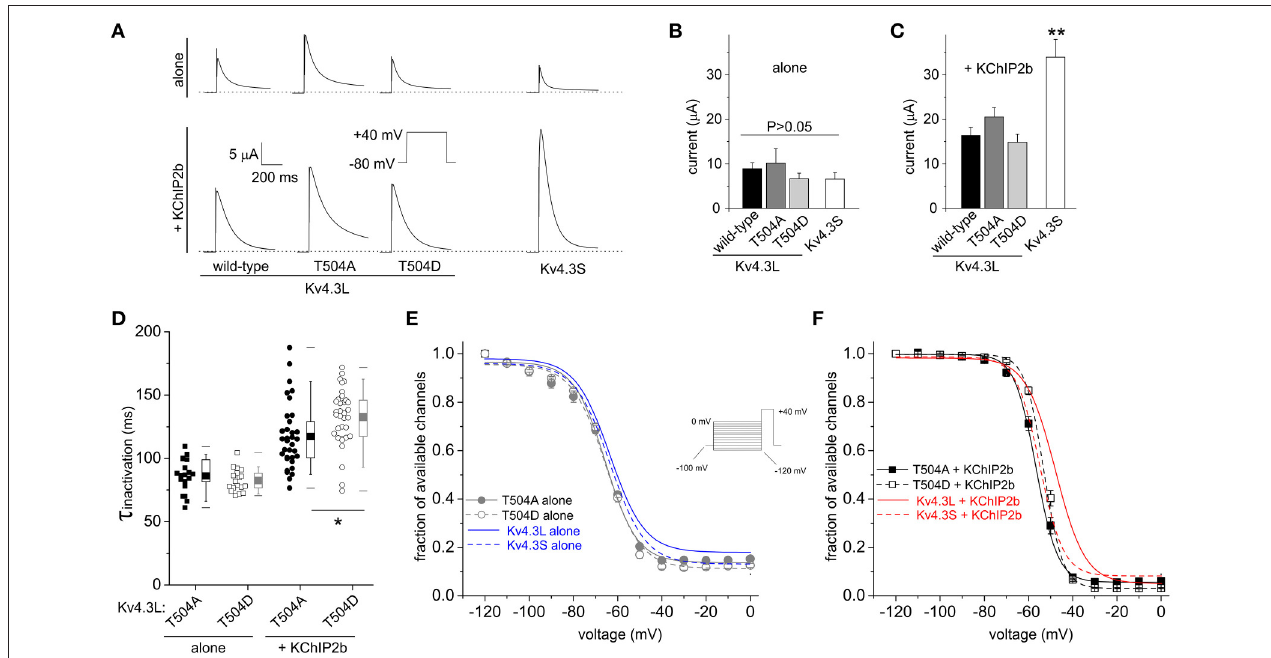
FIGURE 4 | Kv4.3L T504 mutations alter inactivation rate and voltage dependence only with KChIP2b co-expression. (A) Exemplar current traces recorded at + 40 mV from Xenopus oocytes expressing Kv4.3L (wild-type, T504A or T504D) or Kv4.3S, alone or with KChIP2b (voltage protocol inset). Zero current level indicated by dashed line. (B) Mean ± SEM peak currents at + 40 mV for oocytes expressing Kv4.3 variants as in (A) , in the absence of KChIP2b ( n = 8–15). (C) Mean ± SEM peak currents at + 40 mV for oocytes expressing Kv4.3 variants as in (A) , with KChIP2b ( n = 21–25). ** P < 0.01 vs. other + KChIP2b groups. (D) Box plots showing individual and mean ± SEM values for τ of inactivation at + 40 mV of T504A and T504D Kv4.3L, with ( n = 34) vs. without ( n = 17–21) KChIP2b, recorded as in (A) . * P < 0.05. (E) Mean ± SEM fraction of available channels/voltage relationship for T504A and T504D Kv4.3L vs. Kv4.3S in the absence of KChIP2b ( n = 10–13), using the steady-state inactivation protocol (inset). Curves for wild-type Kv4.3 subunits without KChIP2b (from Figure 3 ) included for comparison (blue lines as indicated). (F) Mean ± SEM fraction of available channels/voltage relationship for T504A and T504D Kv4.3L vs. Kv4.3S, with KChIP2b ( n = 26–31), using the steady-state inactivation protocol as in (E) . Curves for wild-type Kv4.3 subunits with KChIP2b (from Figure 3 ) included for comparison (red lines as